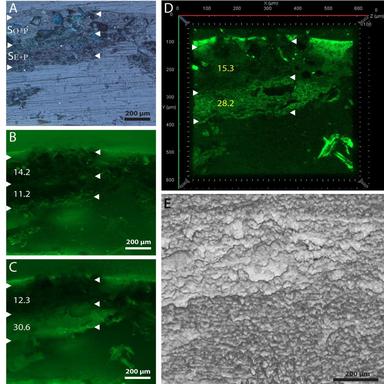
Cross section images of the bluish green coloured micro (model) sample, containing the pigment verdigris, photographed prior to antibody hybridisation using the reflected-light brightfield observation (texp 2 ms, frame A) and the widefield fluorescence observation (texp 600 ms, frame B) modes. After antibody hybridisation, the sample was again captured in the widefield fluorescence observation mode under the same illumination conditions (frame C) and was laser scanned using confocal fluorescence microscopy